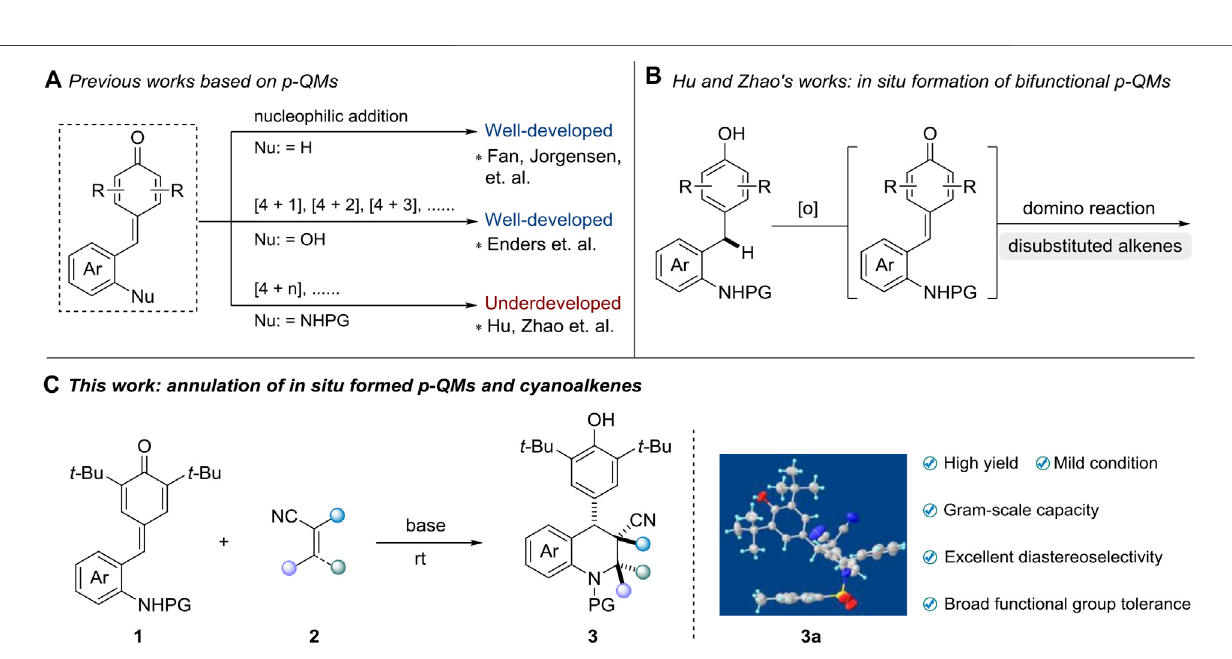
Frontiers in Chemistry |